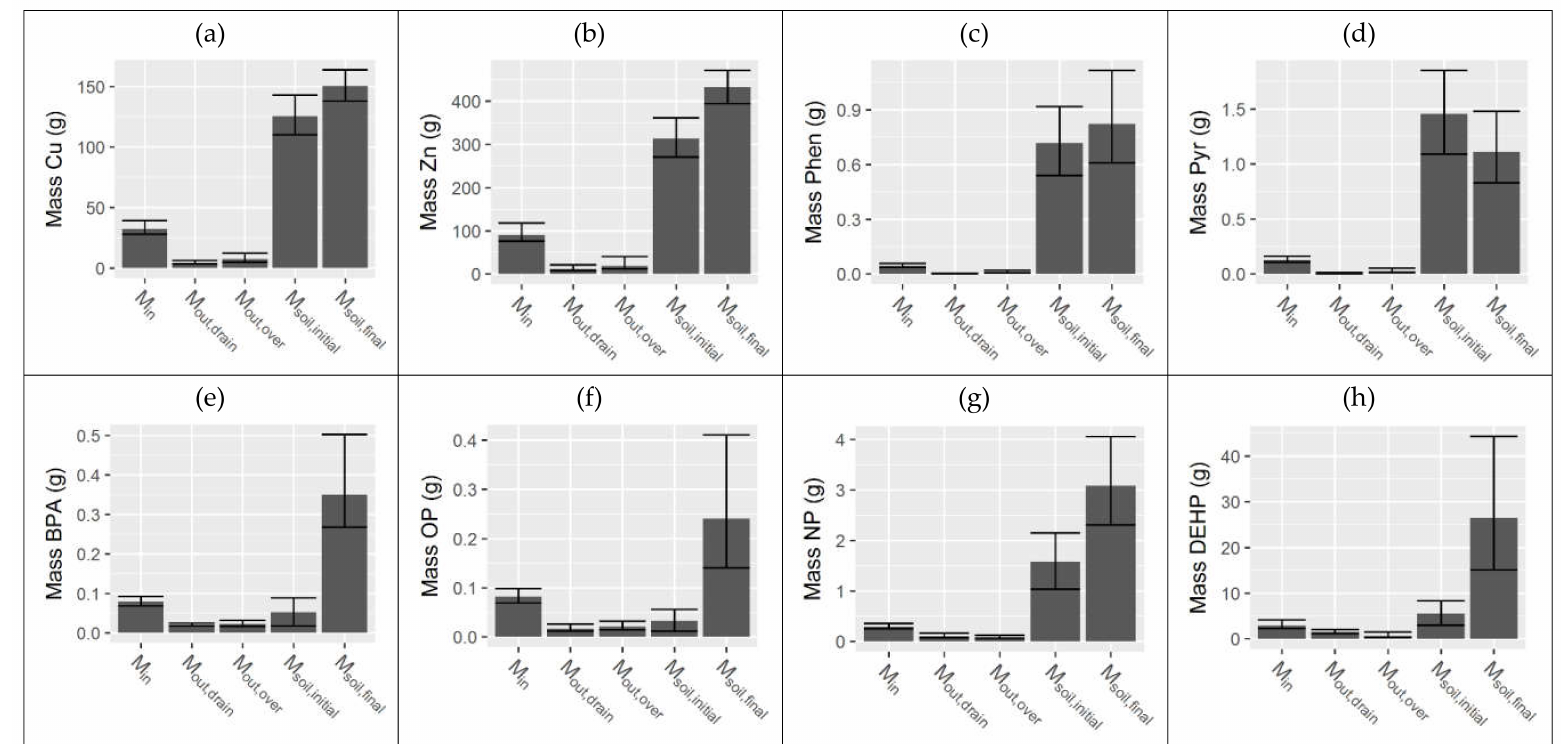
Figure 8. Individual mass balance terms associated with water fluxes (inlet mass from road runoff– M in , outlet mass from drain– M out,drain , outlet mass from overflow– M out,over ) and soil (initial mass stored in soil– M soil,initial , final mass stored in soil– M soil,final ) for ( a ) copper, ( b ) zinc, ( c ) phenanthrene, ( d ) pyrene, ( e ) bisphenol-A, ( f ) octylphenol, ( g ) nonylphenol and ( h ) bis(2-ethylhexyl) phthalate. Bars represent medians, while error bars represent the 95% confidence